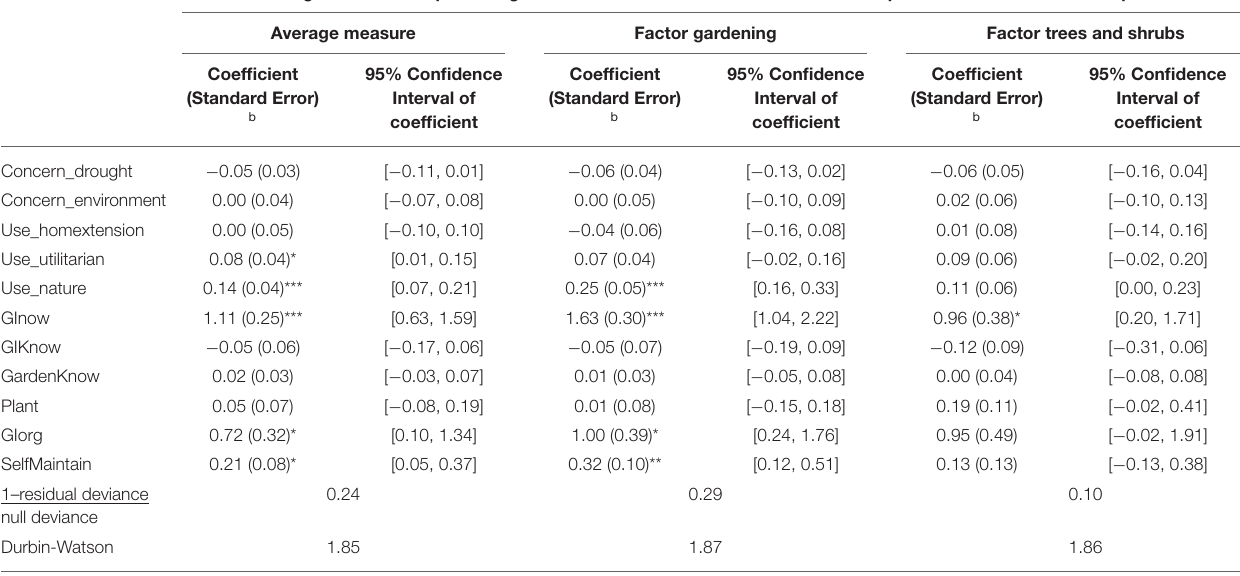
TABLE 3 | Results for the models predicting the average likelihood to install GI and its separate dimensions from cognitive and experiential measures, including environmental concern (Concern_drought, Concern_environment), knowledge of gardening (GardenKnow), knowledge of GI (GIKnow), uses of outdoor space (Use_homextension, Use_utilitarian, Use_nature), level of self-maintenance of outdoor space (SelfMaintain), experience planting vegetation (Plant), previously installed GI features (GInow), and level of awareness of and engagement with local GI initiatives (GIorg). Variable Regression model predicting likelihood to install additional GI features in private residential outdoor